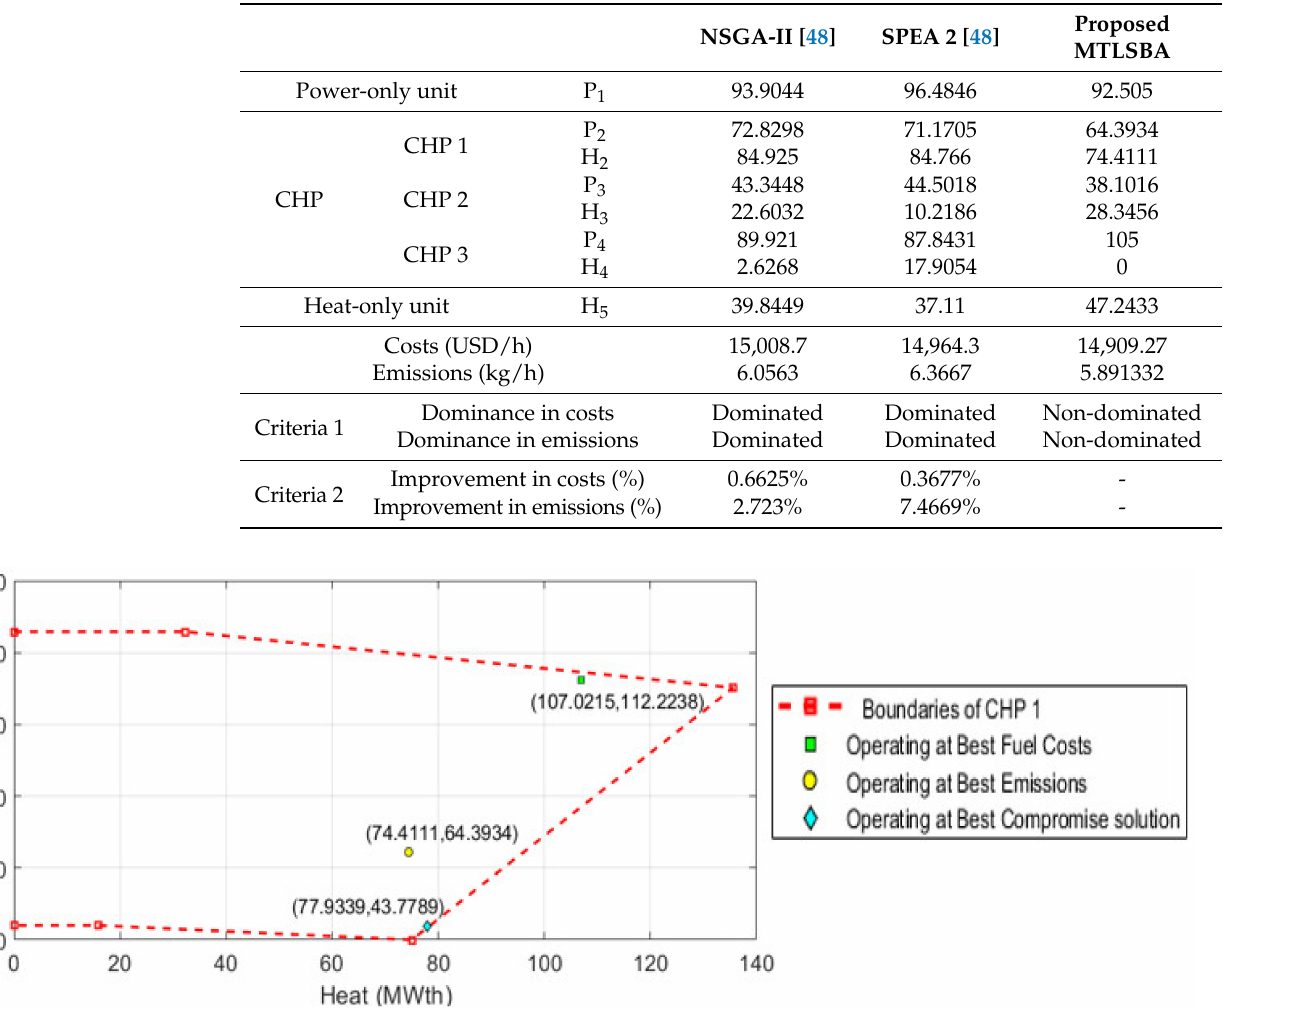
Figure 7. CHP 1 operating point versus its boundaries.